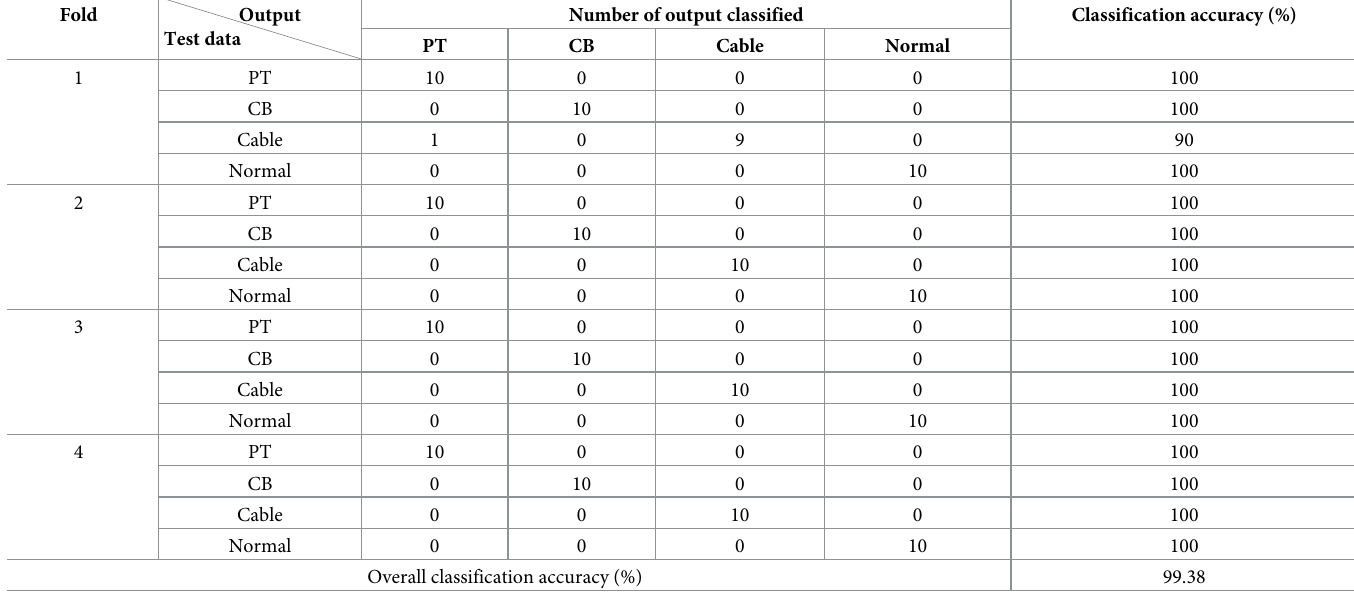
Table 8. Classification results using GSA-ANN based on 4-fold cross validation.